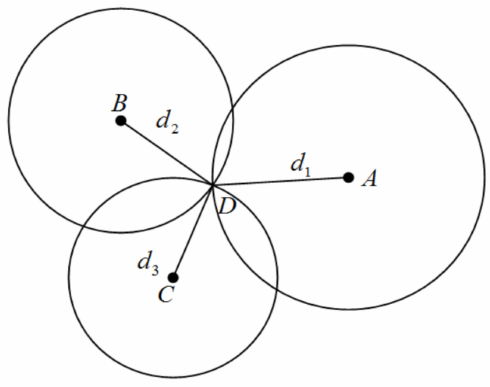
Figure 2. Geometric position of fixed anchors and the